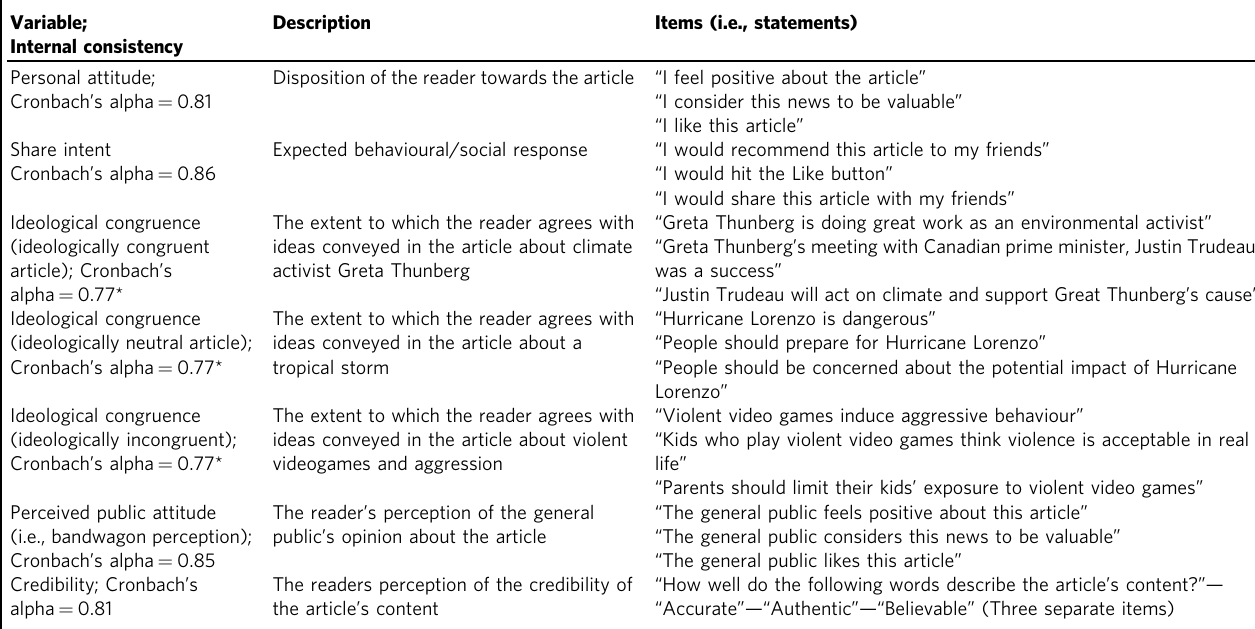
Table 2 Outcome variables with internal consistencies, descriptions, and items.